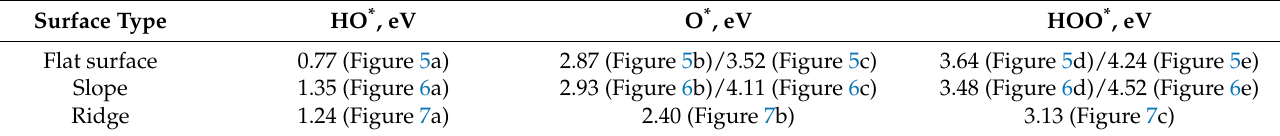
Table 2. Adsorption energies of oxygen evolution reaction (OER) intermediates on different types of surfaces.